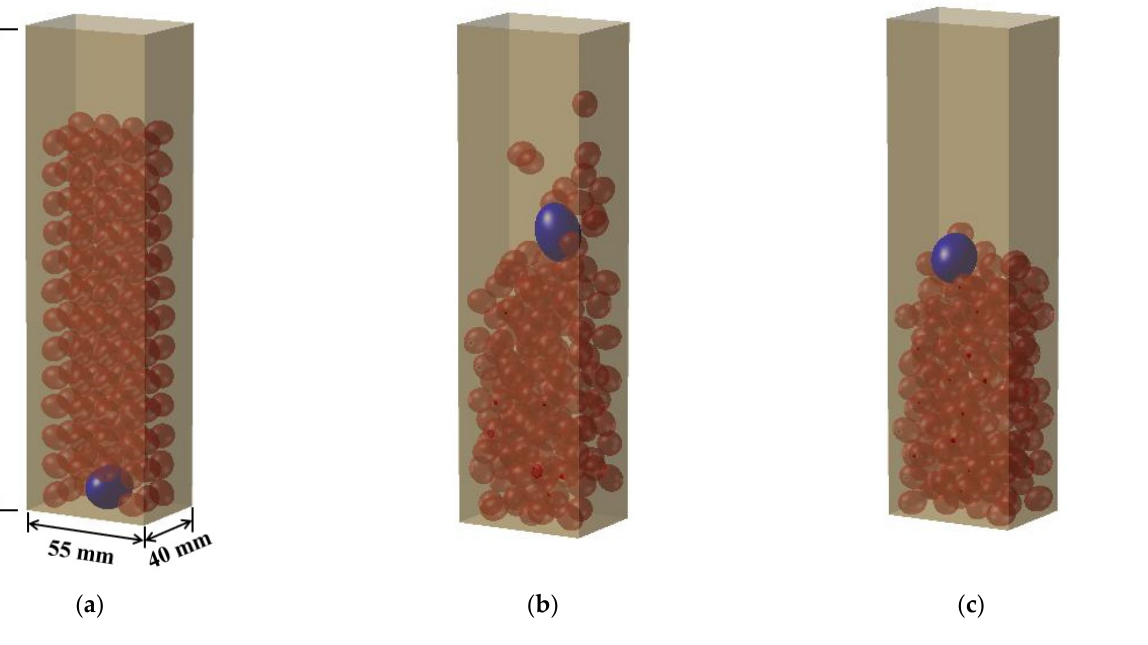
Figure 9. States of the Brazil nut effect. ( a ) initial state; ( b ) final state under M1; ( c ) final state under M4. under